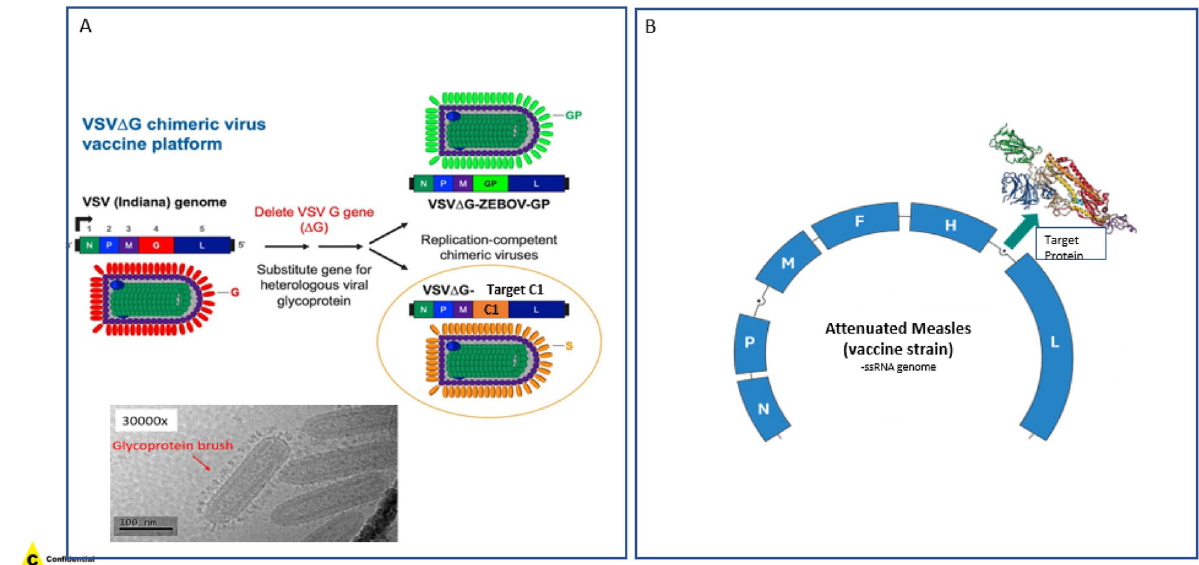
Figure 1. Structure of two experimental live virus vaccine candidates. ( A ) Surface glycoprotein of vesicular stomatitis virus (VSV) is replaced by target protein by genetic engineering. Cryo-EM confirms the bullet shaped structure and glycoprotein presence on surface of the VSV viral vector. ( B ) Replication competent attenuated Measles virus has a target protein sequence insert for expression upon